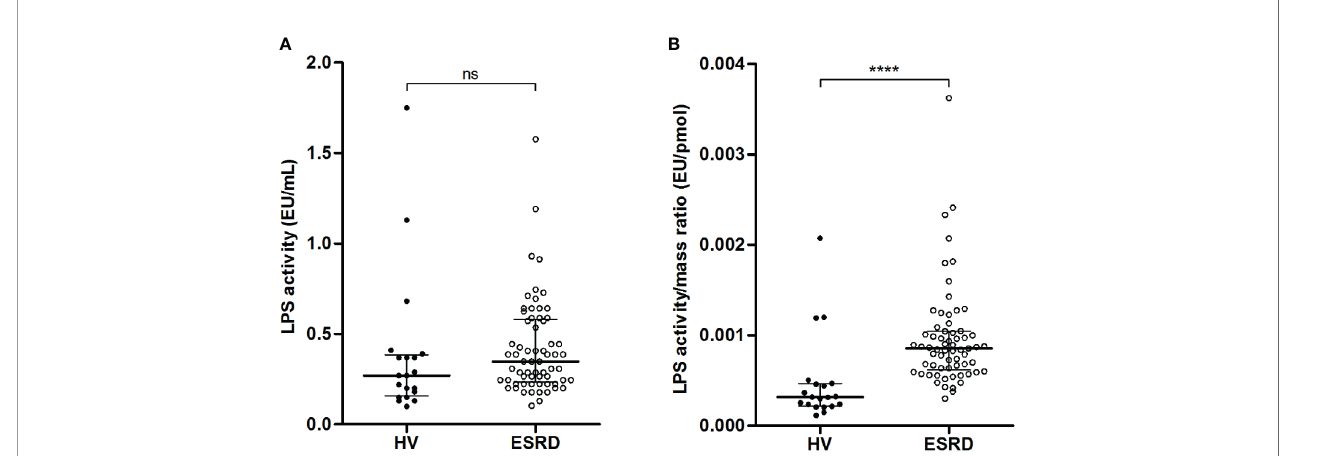
FIGURE 2 | Relationship between quantity and activity of circulating LPS in end-stage renal disease (ESRD) patients and healthy volunteers (HV). Comparison of LPS activity (A) and LPS activity to mass ratio (B) between ESRD patients (n = 68) and healthy volunteers (n = 20). LPS quantity and LPS activity were measured in serum by HPLC/MS/MS method and LAL test respectively. Bars and errors bars are expressed as median with interquartile range. Mann-Whitney U test of HV versus ESRD patient ’ s values, **** p < 0.0001, ns, not signi fi cant. HPLC/MS/MS, high performance liquid chromatography (HPLC) coupled with mass spectrometry (MS/MS); LAL, Limulus amebocyte lysate, LPS, lipopolysaccharide.